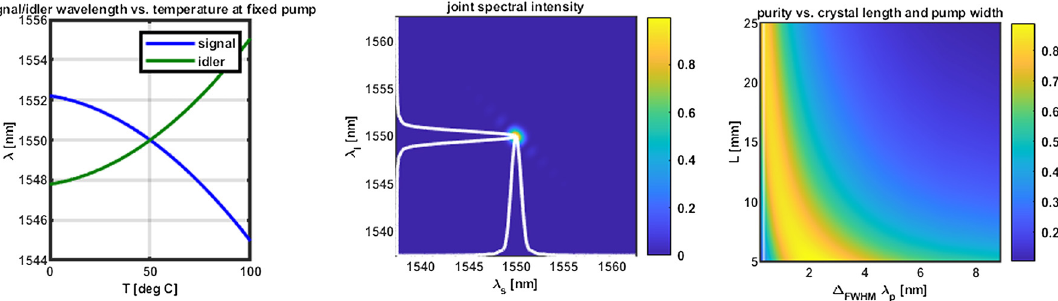
Figure 10: Computational analysis of joint spectral intensity and quantum purity of spontaneously parametric down converted photon pairs. A Type-II SPDC in PPKTP crystal is used as the source for the generation of polarization quantum entangled photon pairs. The pump photon wavelength used here is 775 nm, which gives rise to degenerate signal and idler photons at the communication wavelength of 1550